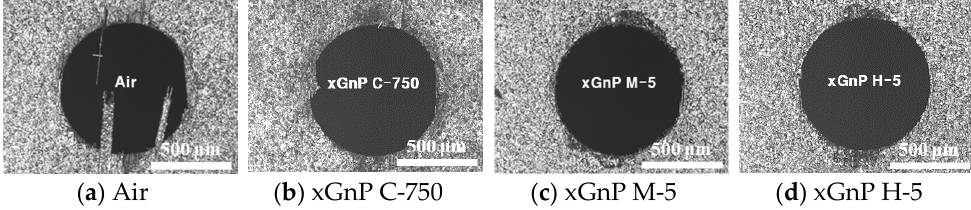
Figure 12. Images of the 28th drilled exit hole of MD-CFRP in each experimental case.